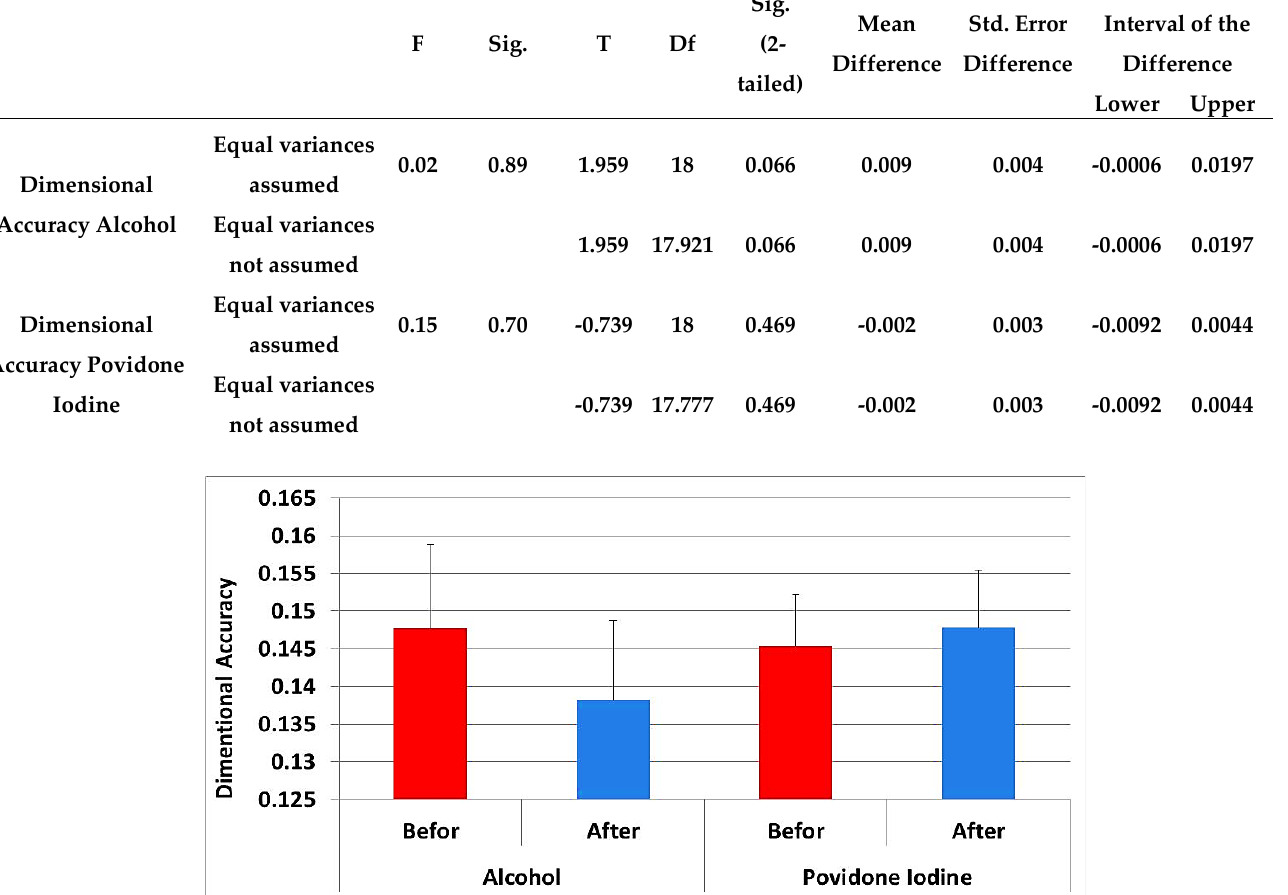
Figure (7): Bar chart of mean values for experimental